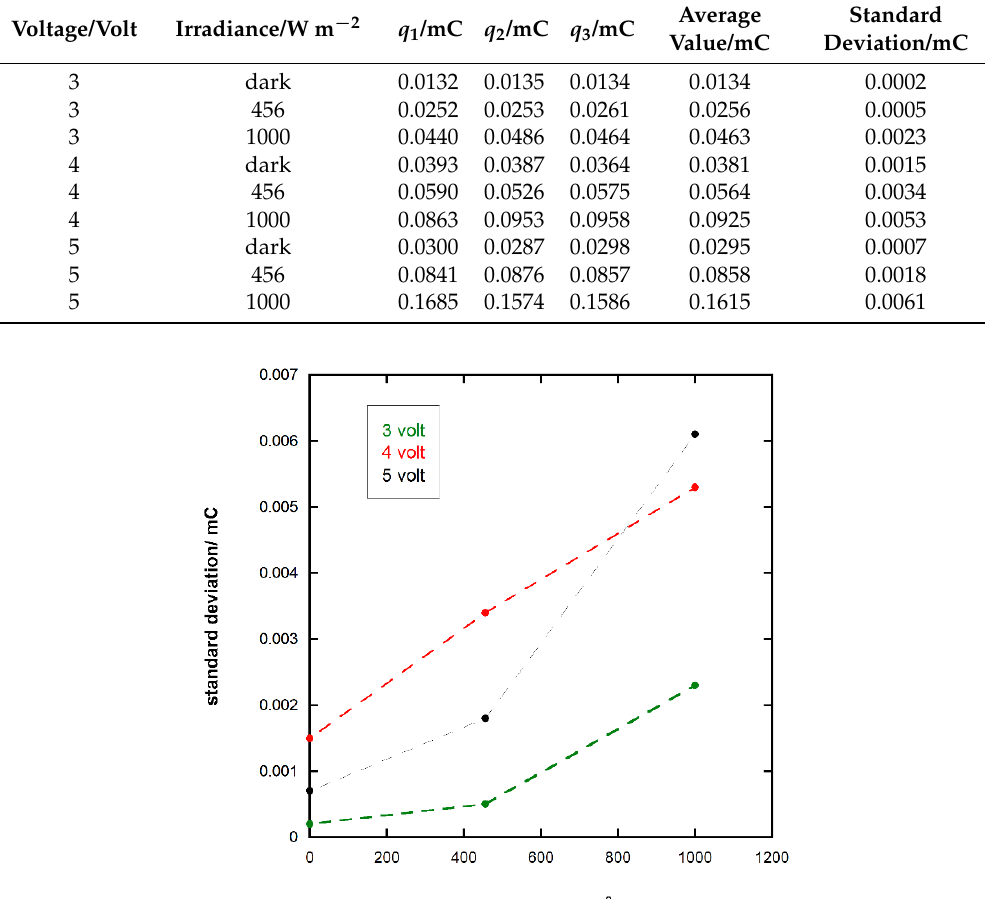
Figure 9. Standard deviation, σ , of the generated charge in photoresponsive device, q , vs. voltage pulses.